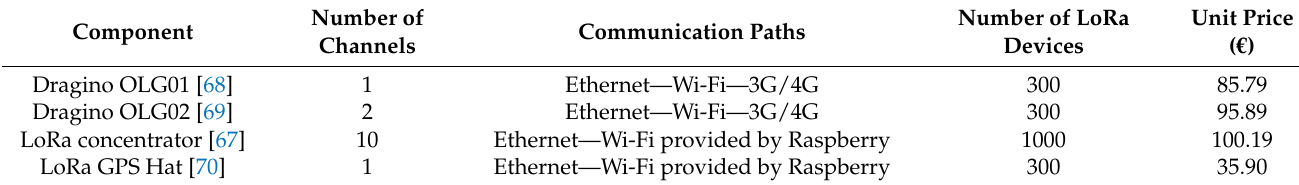
Table 3. Comparison of LoRa gateways and concentrators.